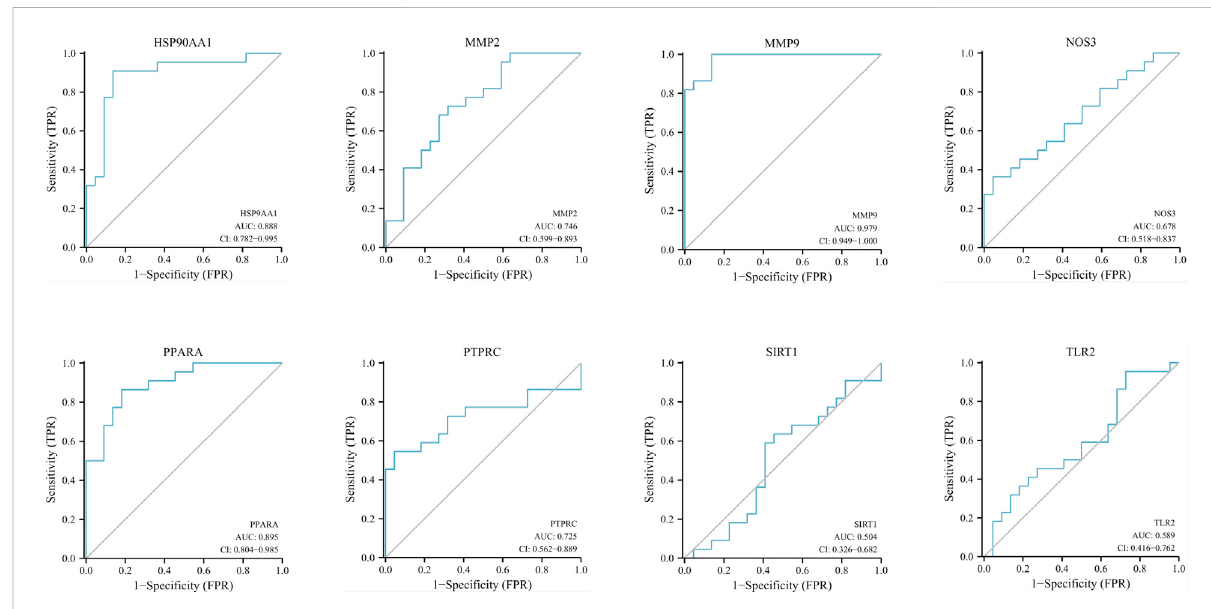
FIGURE 10 Diagnostic ROC curves for eight hub genes in differentiating sepsis from controls. ROC, receiver operating characteristic; AUC, area under the